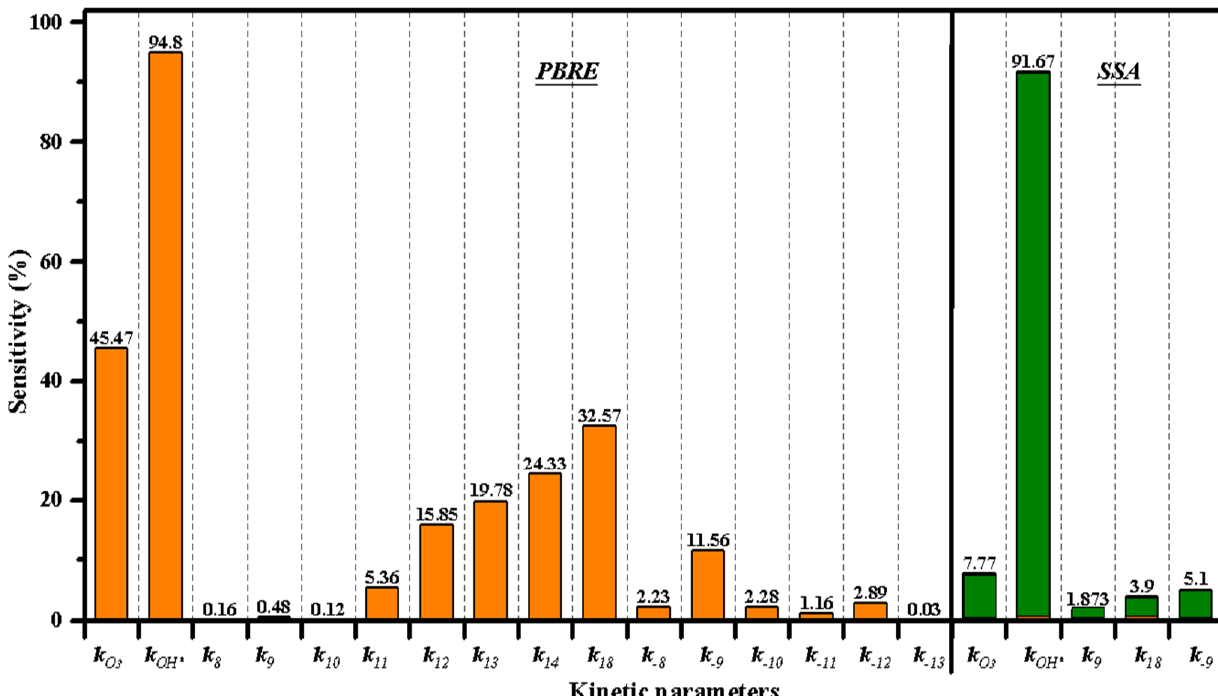
Figure 6. Sensitivity analysis for the proposal of kinetic models based on elemental reactions (cyan bar) and SSA (green